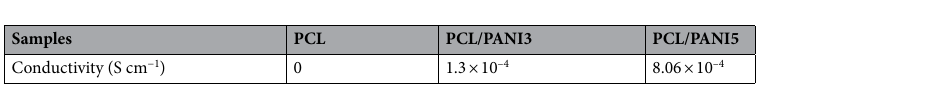
Table 3. Electrical conductivity of nanofibers with 3 and 5 wt.%